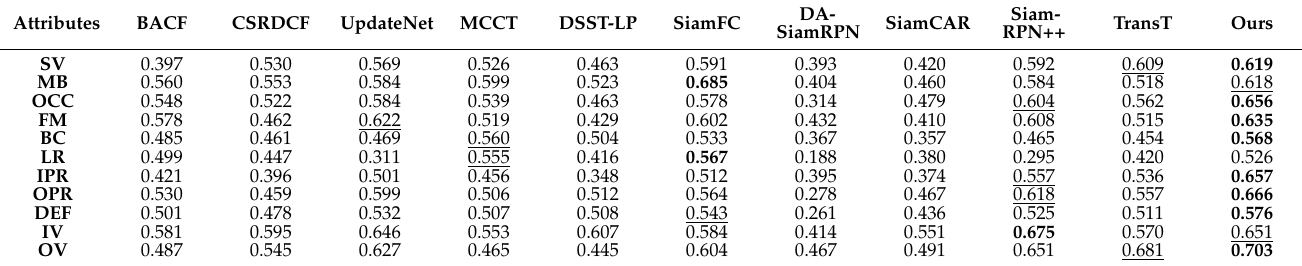
Table 6. Comparison with the other trackers in terms of success rate on